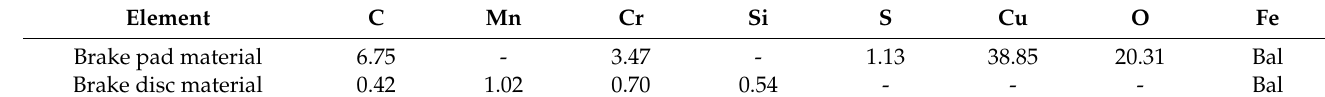
Table 1. Chemical composition of braking materials (wt%).